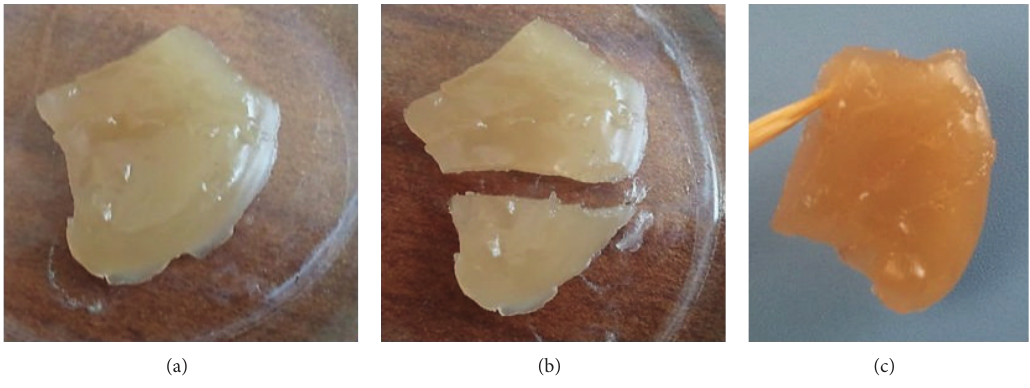
Figure 5: Self-healing